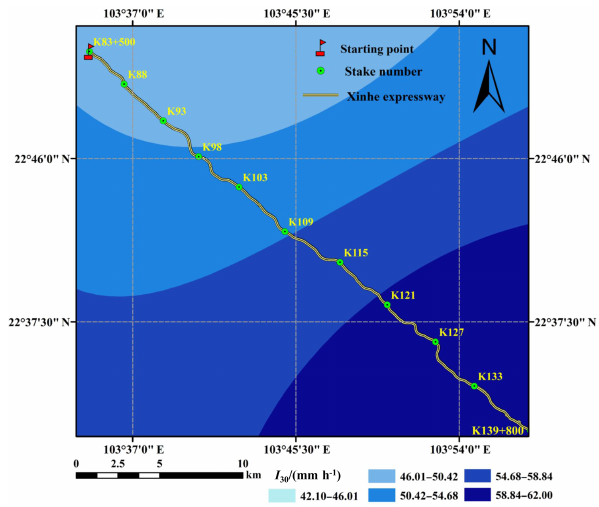
Figure 14. Rainfall intensity interpolation results under a 20-year return